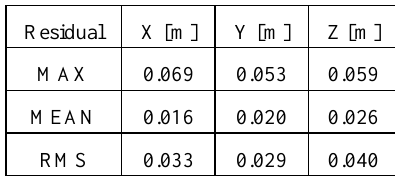
Figure 6. An illustration of the executed flight